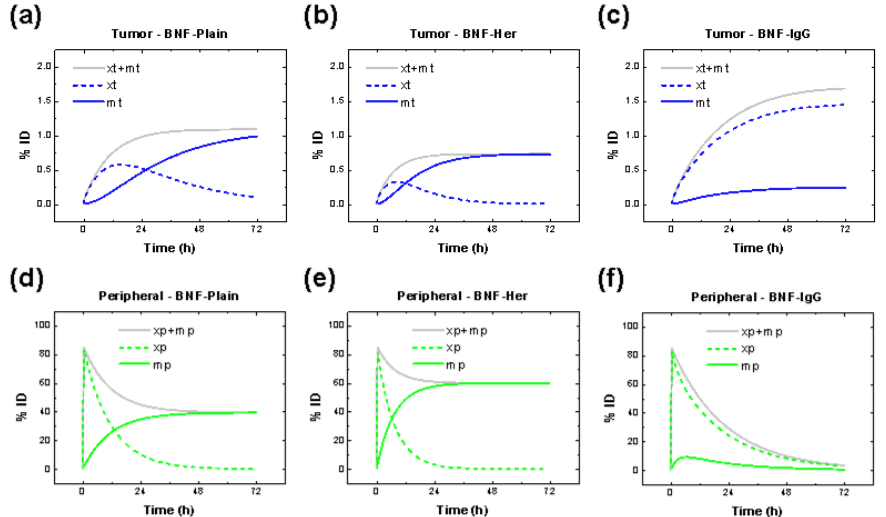
Figure 3. Simulated PK profiles for 100-nm BNF ® nanoparticles. Simulated tumor and peripheral retentions of 100-nm BNF-Plain ( a , d ), BNF-Her ( b , e ), and BNF-IgG ( c , f ) nanoparticles. Dashed lines represent passive retention, solid-colored lines represent active retention by macrophages, and solid-gray lines represent the sum of passive and active retentions. Simulations suggest that resident macrophages dominate tumor and peripheral active retention of BNF-Plain and BNF-Her nanoparticles about 12 h after administration. Meanwhile, passive retention of BNF-IgG would be more significant.